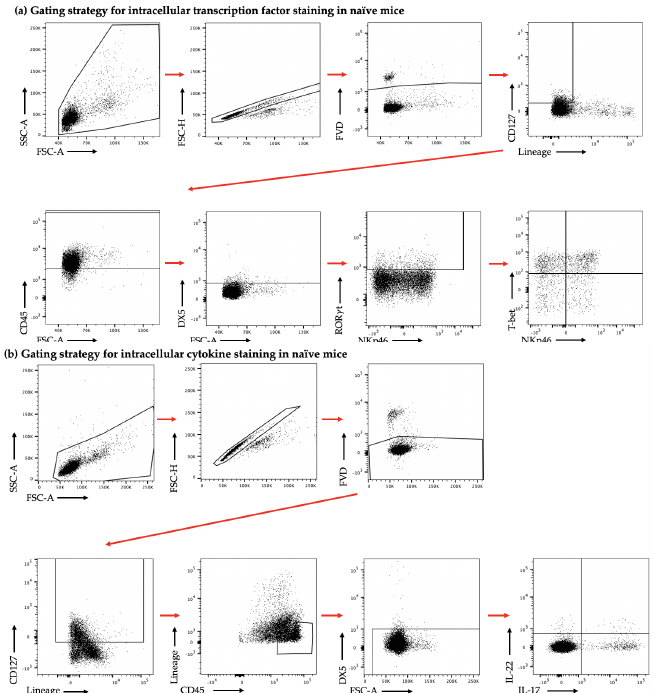
Figure A1. Representative dot plots of the flow cytometry gating strategy of naïve mice. The popu- lations were examined through flow cytometry. The gating strategies used for the ( a ) transcription factor staining analyzed in Figures 1 and 2 and ( b ) for the intracellular cytokine staining assessed in Figure 3.